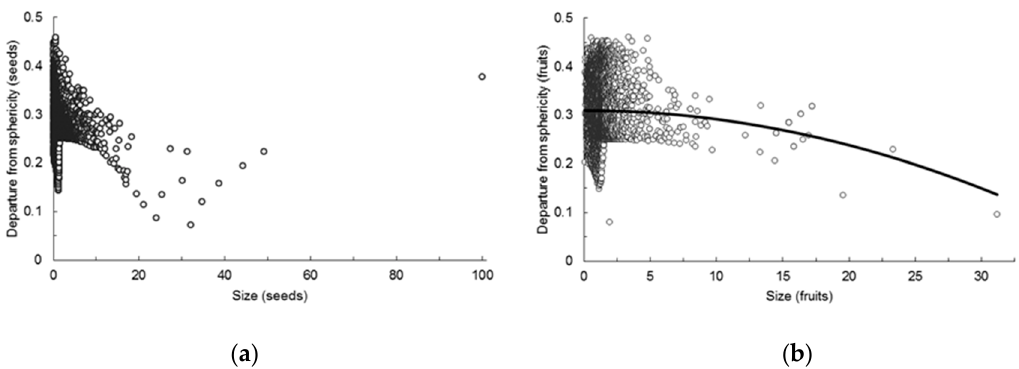
Figure 2. Observed and estimated relationship between departure from sphericity (square root transformed) and size (volume cubic root transformed) of: ( a ) Seeds; ( b ) fruits. All diaspores with known length and width, thickness estimated by Equation (1).